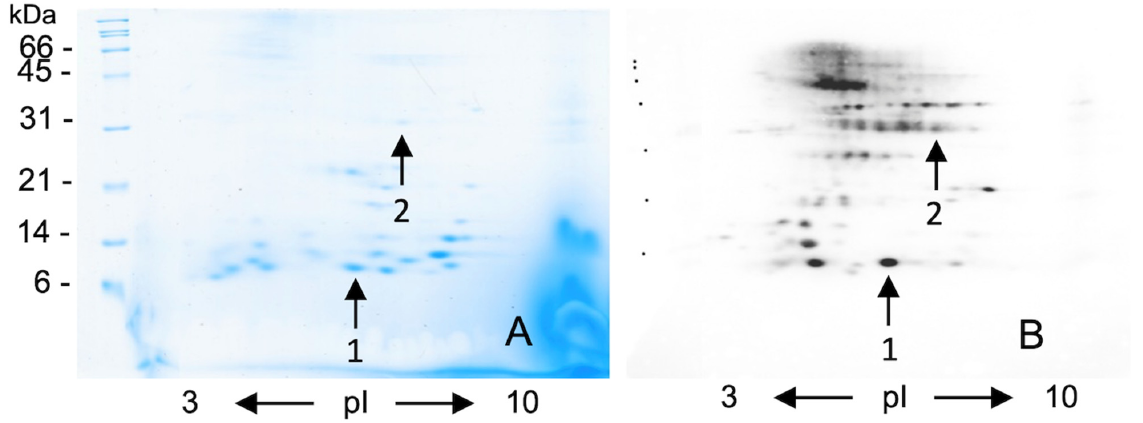
Figure 2. WSSP stained by Coomassie blue 2-DE (panel ( A )) and immunodetected by IgE-Blotting with the pooled sera of bakers with work-related symptoms (panel ( B )). The arrows of panel B indicate the spots identified by nanoHPLC-Chip-tandem MS/MS. Spot highlighted by arrow 1 was identified as a monomeric alpha amylase inhibitor, while spot indicated by arrow 2 as a glucose/ribitol dehydrogenase. Further spots with MW in the range of about 21–27 kDa are well visualized by IgE blotting (panel ( B )) but not stained by Coomassie in 2-DE.